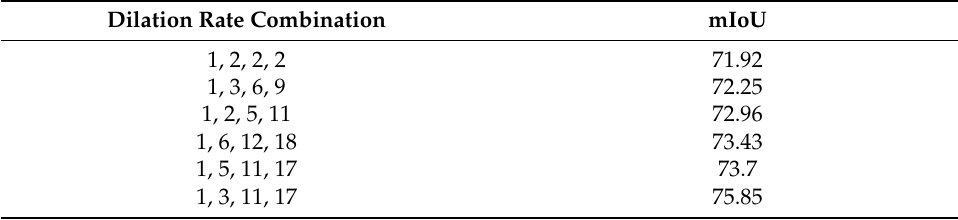
Table 5. Effects of different dilation Rates on the performance of the ASPP